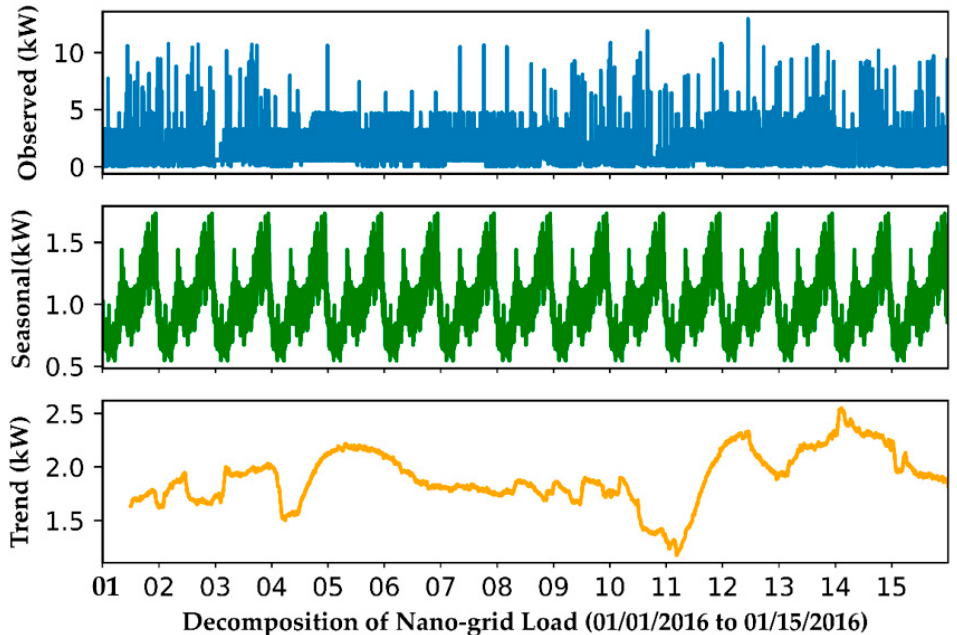
Figure 6. Decomposition of nanogrid load (01/01/2016 to 01/15/2016). Weather features in the dataset are Temperature (°C), Apparent Temperature (°C), Humidity, Cloud Cover, Dew Point, Pressure (Bar), Wind Speed (m/s), Visibility, and Precipitate Intensity. Their filtering is discussed in the next Section 4.2.